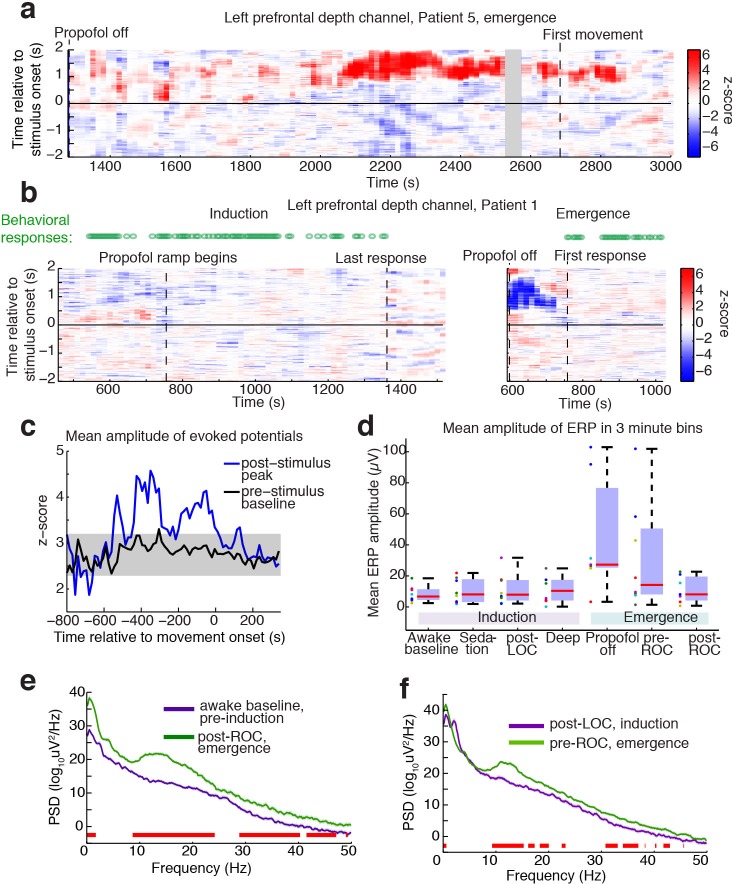
Large evoked potentials occur during a brief transitional state.(A) Evoked potentials in a patient with a long emergence recording, shows that LPs appear as the propofol concentration declines, and then subside shortly after the patient's first spontaneous movement (seen at ~2200–2900 s). Z-scored ERPs averaged in sliding window of 60 s every 15 s. Gray shading covers window with insufficient (<8) events for averaging. (B) Normalized evoked potentials in a patient with both an emergence and an induction recording. The pattern is asymmetric, with stimulus-locked LPs occurring only during emergence. Z-score shows mean ERP normalized to the pre-stimulus baseline in each time window. This patient was under light anesthesia at the end of surgery and LPs appeared even before the propofol infusion was turned off. (C) Amplitude of the peak ERP across all subjects, locked to ROC (movement onset) and normalized to pre-stimulus baseline. Evoked potential amplitude across all subjects peaks in the 400 s prior to ROC, and then returns to baseline after ROC, indicating that LPs mostly occur in the minutes preceding ROC. As a control, the peak pre-stimulus baseline z-score across subjects is plotted in black, with gray shading indicating its mean value ±3*st.dev. over time. (D) Boxplot of absolute value of mean ERP amplitude at 0.5–1 s post-stimulus in the eight subjects with both induction and emergence recordings. ERPs are small at baseline, sedation, and post-LOC. They are largest in the bin after propofol is turned off and before ROC. (E) Mean spectra across patients within the same 3 min time bins, red bars indicate frequency bands with significant difference (p<0.05, bootstrap). The post-ROC state has greater low-frequency (<2 Hz), alpha/beta (~10–24 Hz) and gamma (~30–50 Hz) power than the awake pre-anesthesia baseline (n = 7 subjects). (F) Same, demonstrates a broadband increase in power above 10 Hz in the emerging state, relative to immediately after LOC during induction (n = 8 subjects). Red bars indicate significant differences at p<0.05 (bootstrap).10.7554/eLife.33250.008Figure 3—source data 1.Mean amplitudes of the ERP for each intracranial subject across conditions.